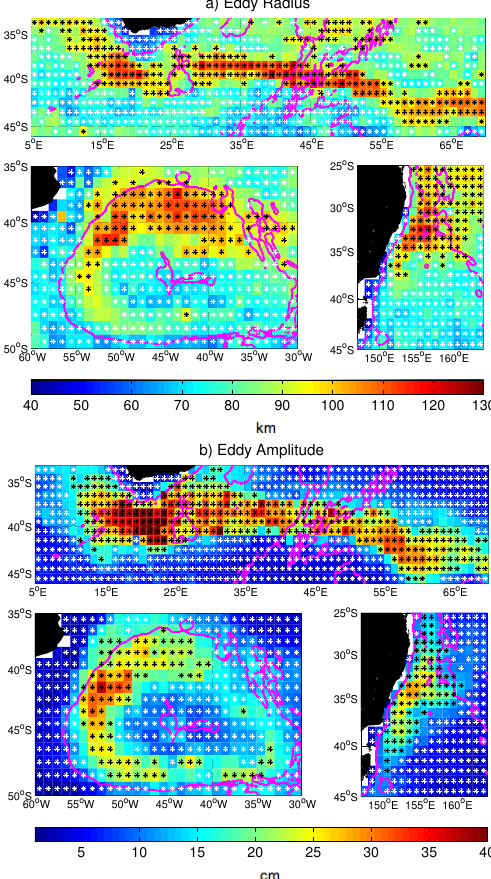
Figure 3. Mean (a) radii (km) and (b) amplitudes (cm) of eddy- like features (lifetime >4 weeks) in the AC, BC and EAC systems in a 1 ◦ × 1 ◦ grid, with magenta lines indicating the 4000, 3000 and 2000m isobaths, respectively. White (black) stars indicate cells with values significantly smaller (higher) than the system mean.